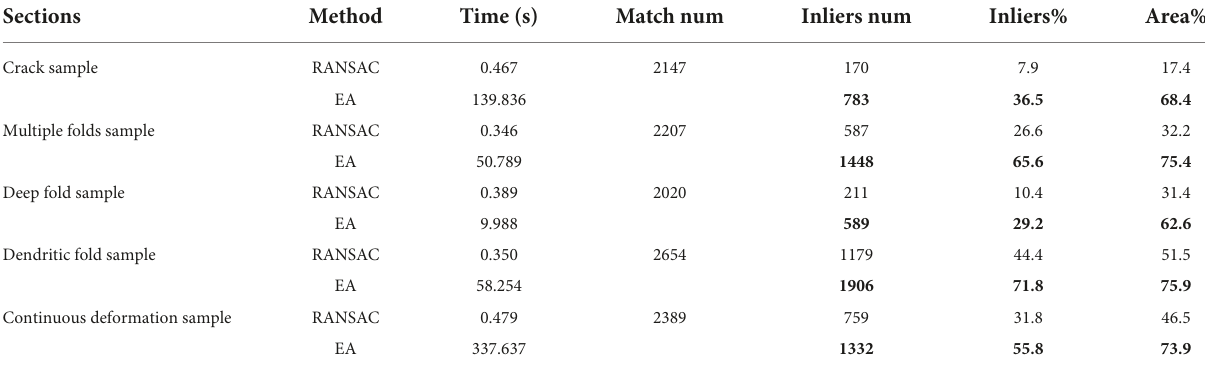
TABLE 1 Quantitative analysis of matching